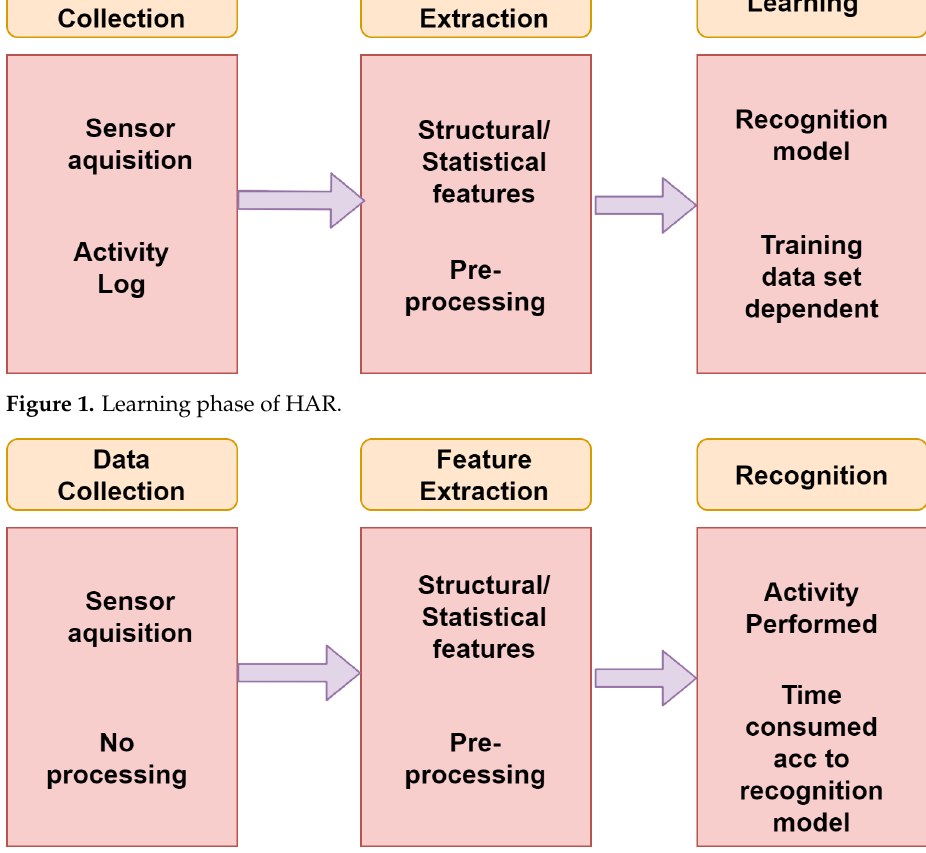
Figure 2. Recognition phase of